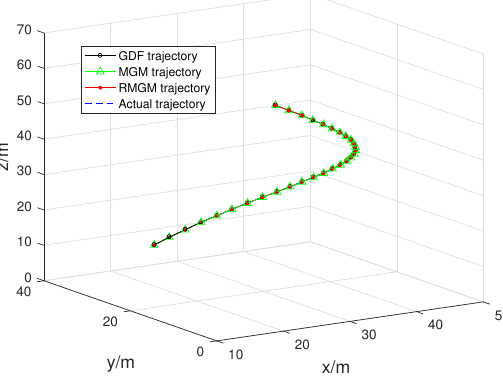
Figure 16. Trajectory prediction of the GDF, MGM, and RMGM models.